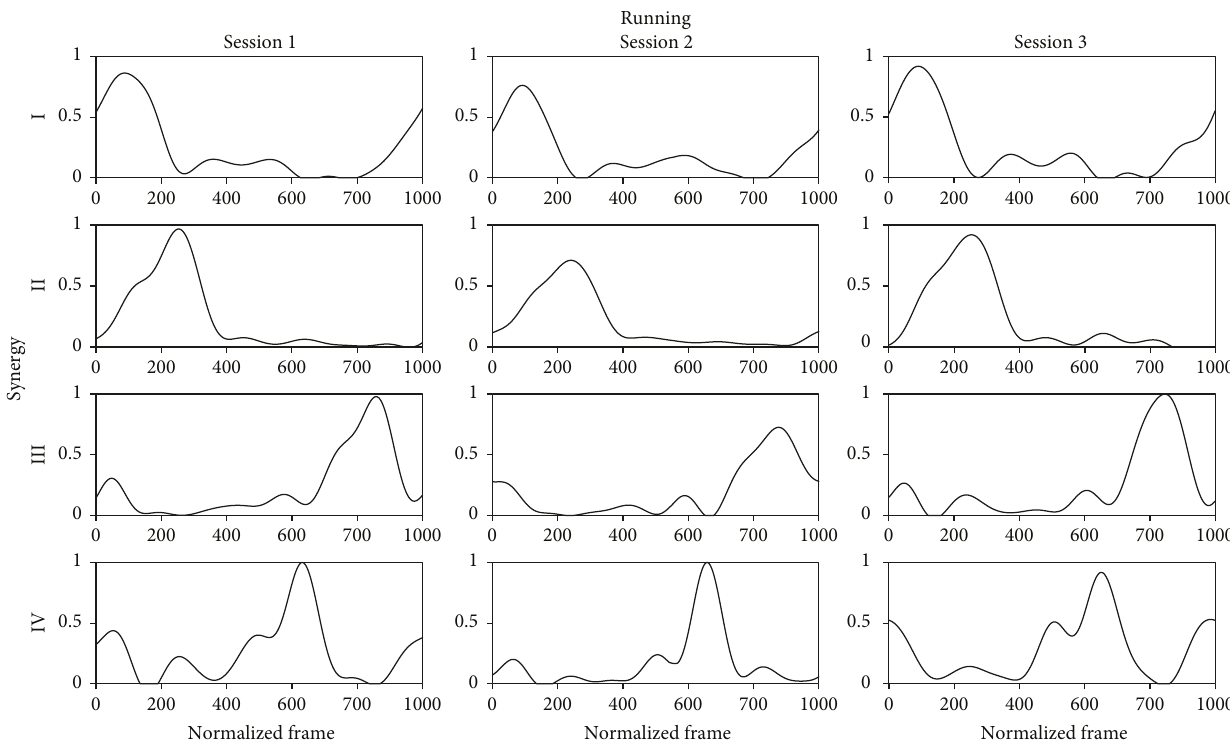
Figure 5: A paradigmatic example of the mean value of the temporal activity pattern in the 4-synergy model related to the running task for one subject for each session. The mean has been obtained averaging the repetitions of the same session. For visualization purposes, temporal activity patterns are normalized to unity. Table 6: Minimum and maximum and relative standard deviation (SD) of the WB VAF